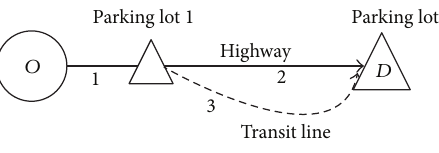
Figure 1: The simple